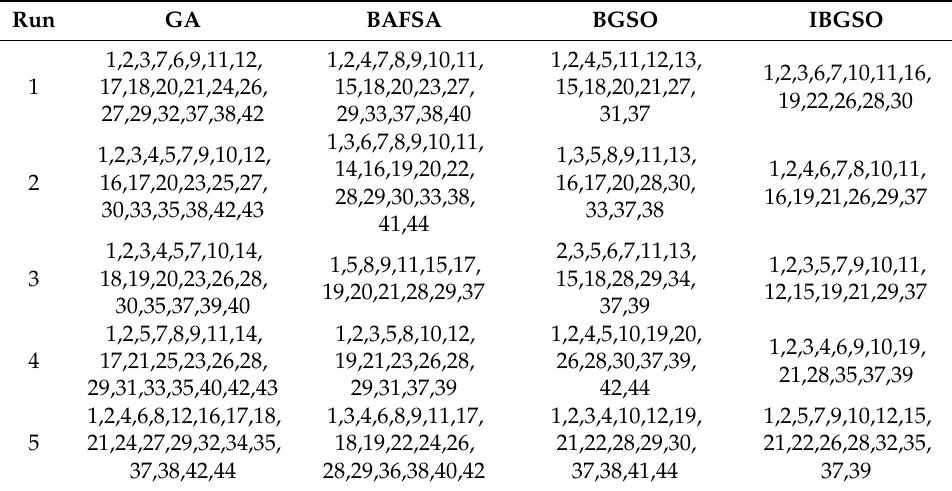
Table 10. Sensor selection results for subject 2 with five runs using the